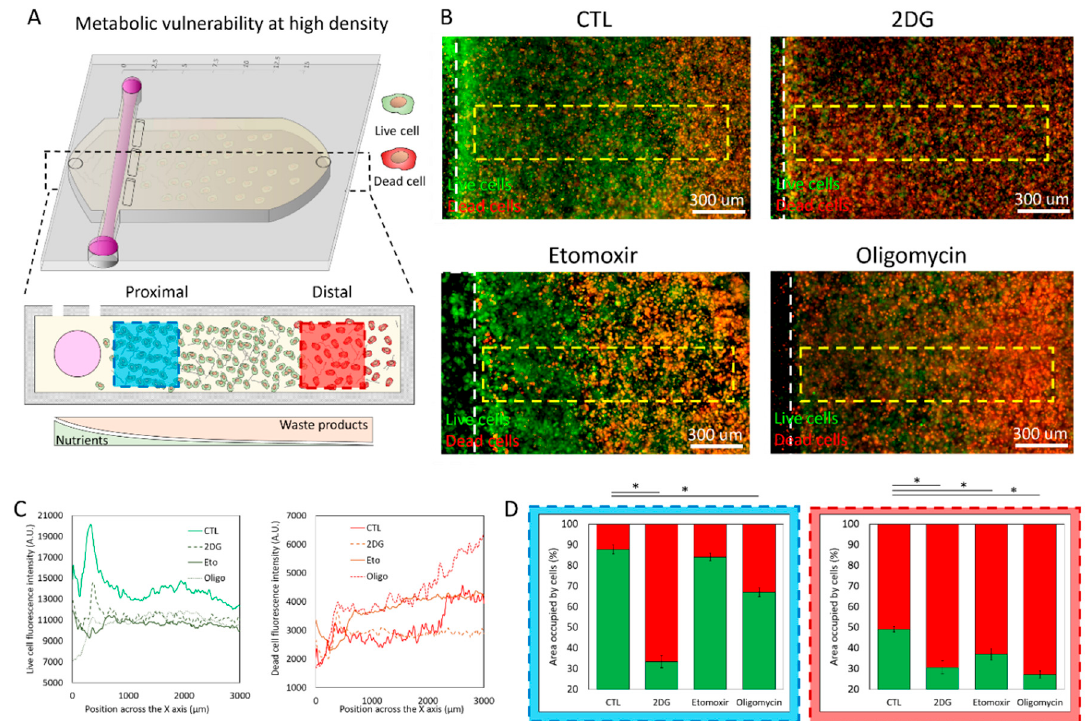
Figure 6. Metabolic vulnerability in high-density cell cultures. ( A ) Breast cancer MCF7 cells were cultured in the tumor-on-a-chip microdevice at 15 million cells/mL for 48 h in culture medium (CTL), 2-Deoxy-D-glucose (2DG), etomoxir, or oligomycin. Cell viability was evaluated using CAM and PI, labelling viable and dead cells in green and red, respectively. ( B ) Fluorescence microscopy images showing cell viability across the collagen hydrogel at low magnification in the presence of culture medium (CTL), 2DG, etomoxir, or oligomycin. ( C ) Graphs show the fluorescence intensity profile of live (green) and dead (red) cells across the delimited region highlighted with a yellow rectangle in “B”. ( D ) Bar graphs analyzing cell viability in the proximal (blue-dotted rectangle) and distal region (red-dotted rectangle) in the presence of 2DG, etomoxir, or oligomycin. Viable percent in green, dead cell percent in red. * denotes p -value < 0.05.